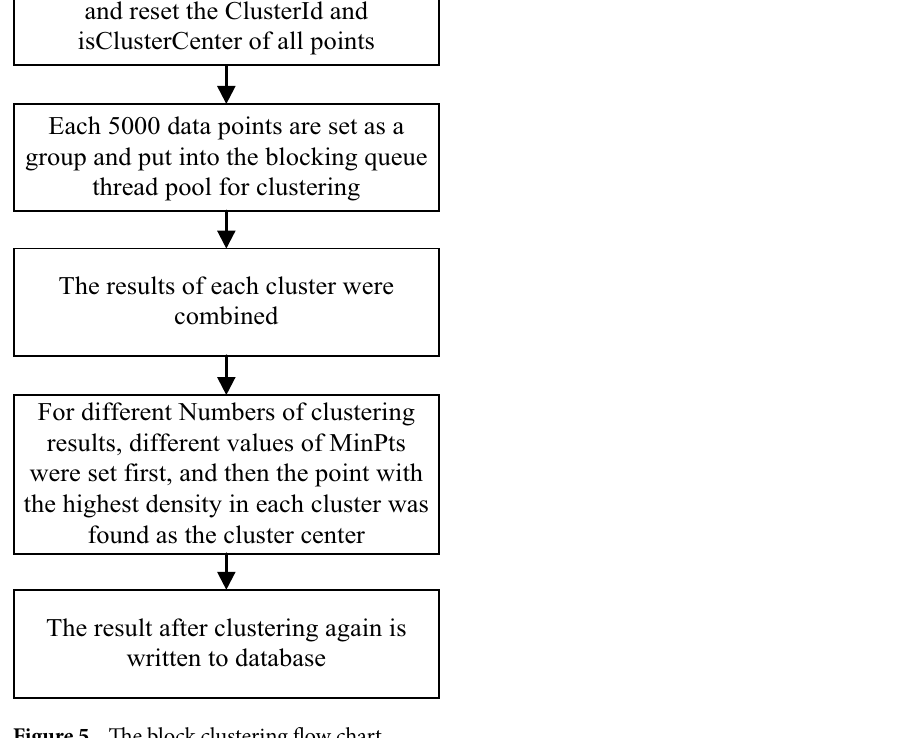
Figure 5. The block clustering flow